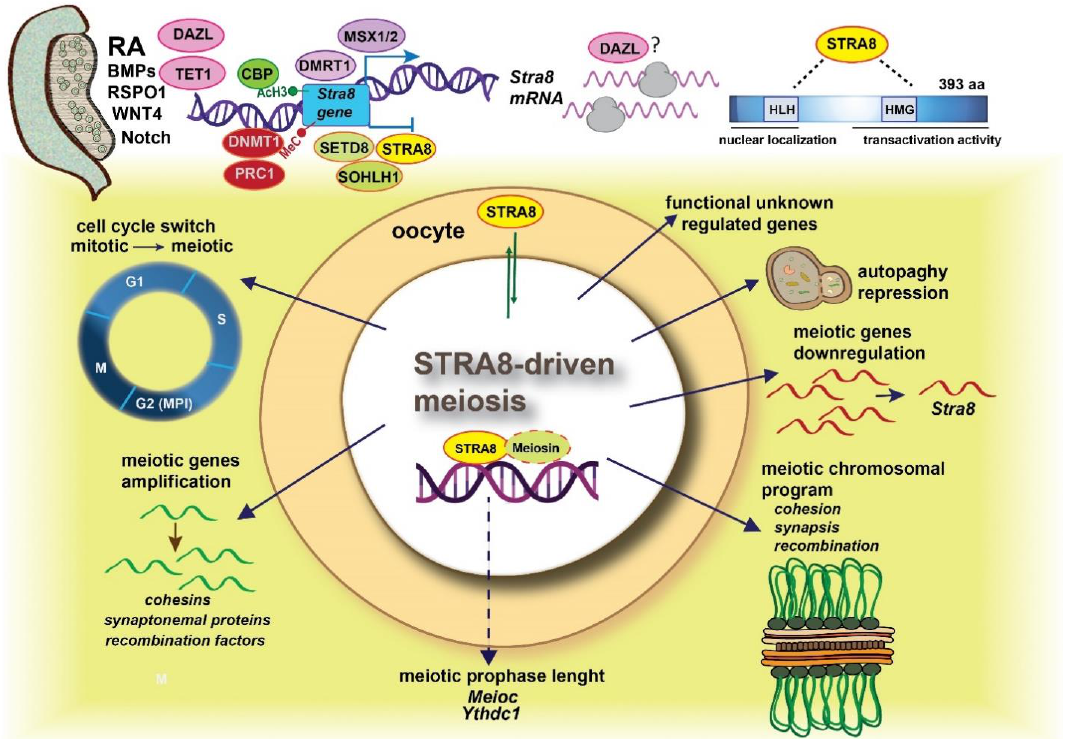
Figure 3. Schematic representation of the main factors so far detected that control the expression of the Stra8 gene and of the functions attributed to the STRA8 protein as transcription factors. For details, see text.